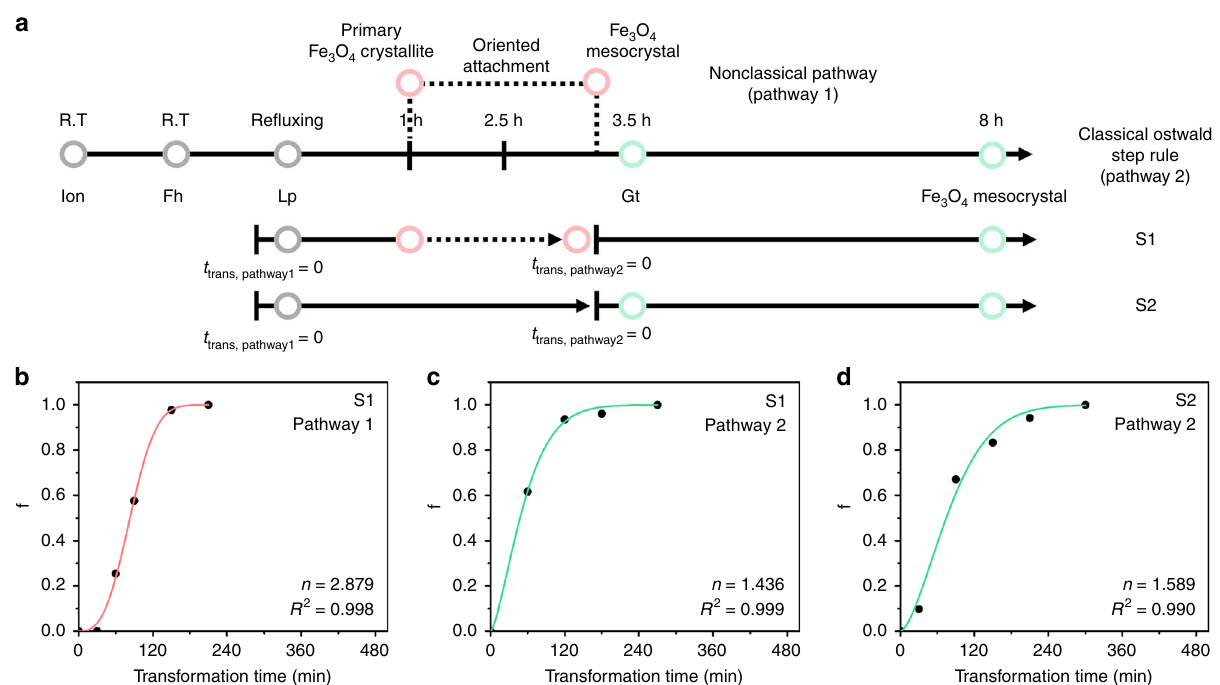
Fig. 4 JMAK Kinetics and schematic illustration of the proposed crystallization model of Fe 3 O 4 . a Timeline of the entire reaction, and JMAK kinetics. Phases at each time are indicated. Solid and dotted lines represent crystallization pathways 1 and 2, respectively. b – d Fitting results of JMAK model of Fe 3 O 4 mesocrystals grown via pathway 1 of S1 ( b ), pathway 2 of S1 ( c ), and pathway 2 of S2 ( d ). Transformation time ( t trans ) = 0 is de fi ned as the starting point of each process. Red and green lines indicate the crystallization pathway 1 and 2,